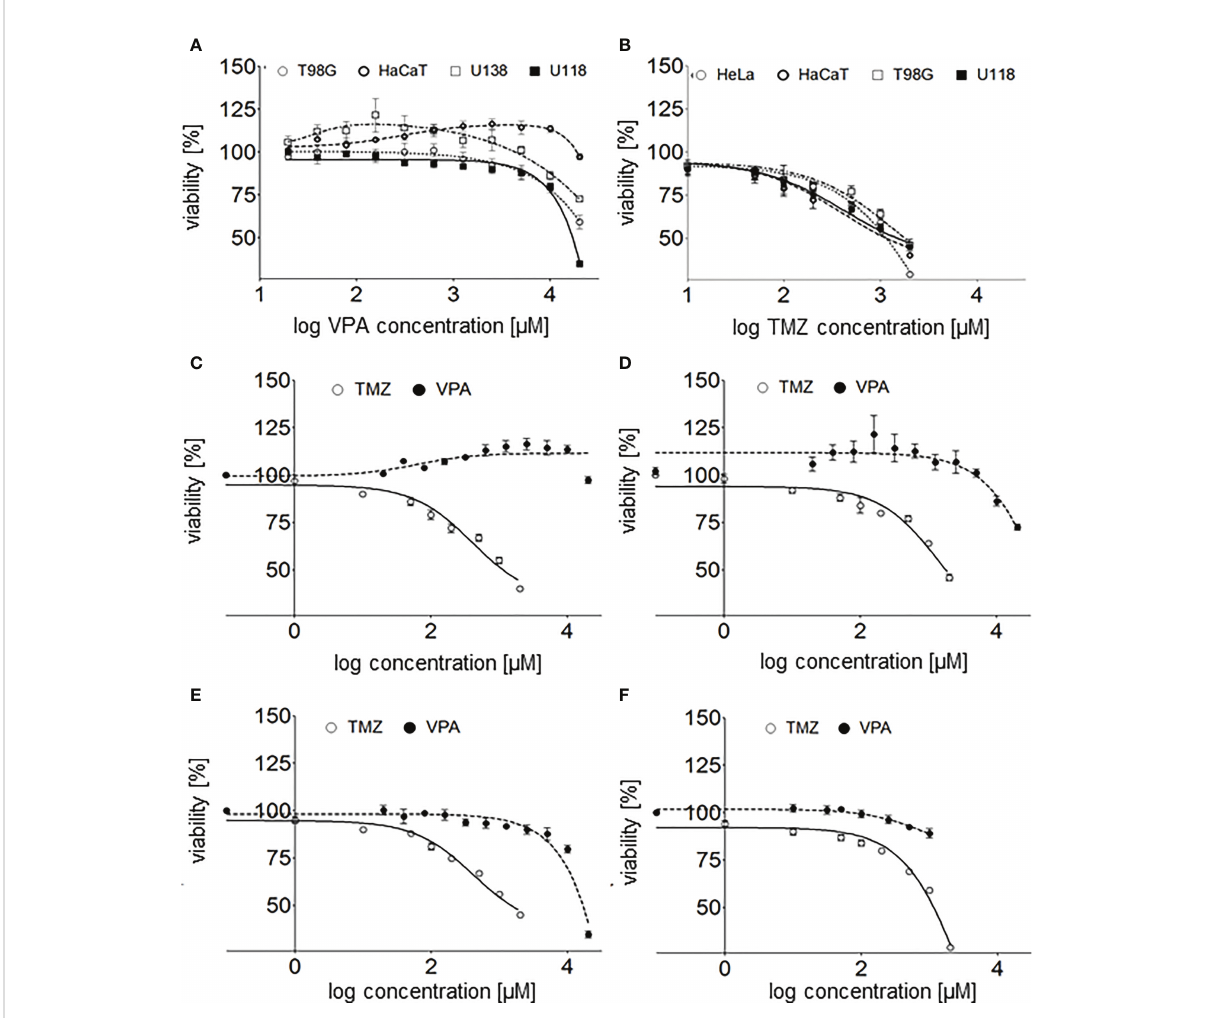
FIGURE 2 (A) - valproic acid ’ s effect on human glioblastoma cell lines (T98G, U118, and U138) and a keratinocyte cell line (HaCaT) viability 24 h after cell culture supplementation with VPA (20-20000 µM; log concentration, 1.3 - 4.3 µM). (B) - TMZ ’ s effect on human glioblastoma cell lines (T98G, U118), a keratinocyte cell line (HaCaT) and an adenocarcinoma cell line (HeLa) viability 24 h after cell culture supplementation with TMZ (1 µM - 2 mM, log concentration 0 – 3.3 µM). The comparison of TMZ and VPA effect on the viability of (C) - U118, (D) - T98G, (E) - HaCaT, and (F) - HeLa cells. Values are the means ± SE of at least four